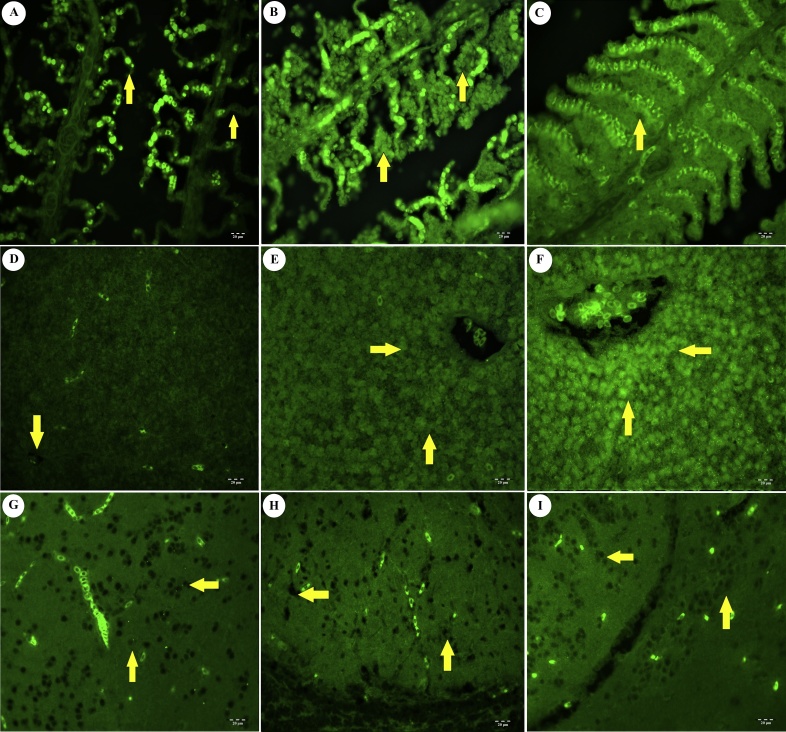
Immunoflorescence staining results of TNF-α (96 h). A). Lamella of gill tissue (arrow). Control group. IF. 20 μm. B) Positive reaction in lamellar cells of gill tissue (arrows). Low dose toxic group. IF. 20 μm. C) Positivity in lamellar cells of gill tissue (arrow). High dose toxic group. IF. 20 μm. D) Liver tissue, vena centralis (arrow). Control group. IF. 20 μm. E) Positive reactions in hepatocytes (arrows). Low dose toxic group. IF. 20 μm. F) Positive reactions in hepatocytes (arrows). High dose toxic group. IF. 20 μm. G) Weak positive reactions in neurons (arrows). Control group. IF. 20 μm. H) Weak positivity in neurons (arrows). Low dose toxic group. IF. 20 μm. I) Positivity in neurons (arrows). High dose toxic group. IF. 20 μm.